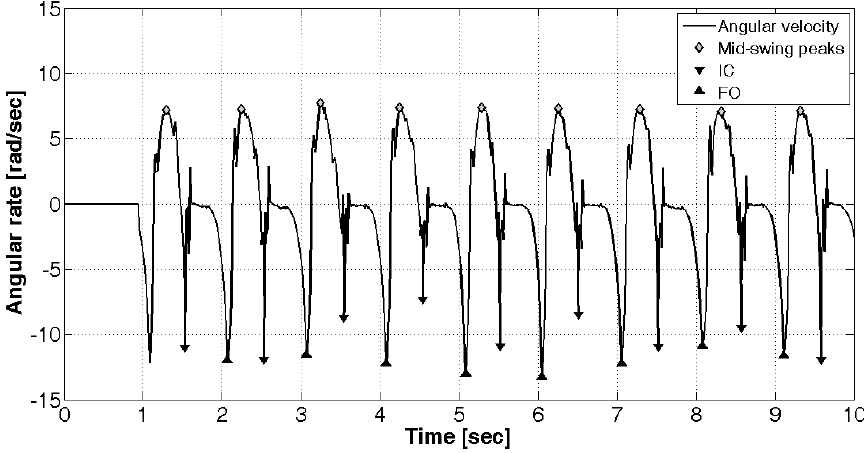
Figure 5. Angular velocity and the detected initial contact (IC) and foot-off (FO)